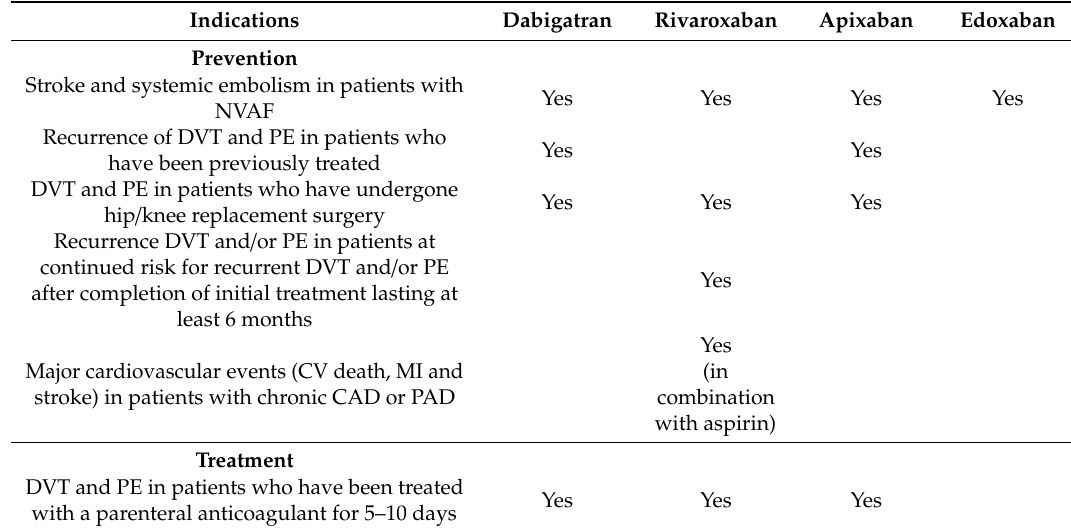
Table 1. Indications for DOACs.